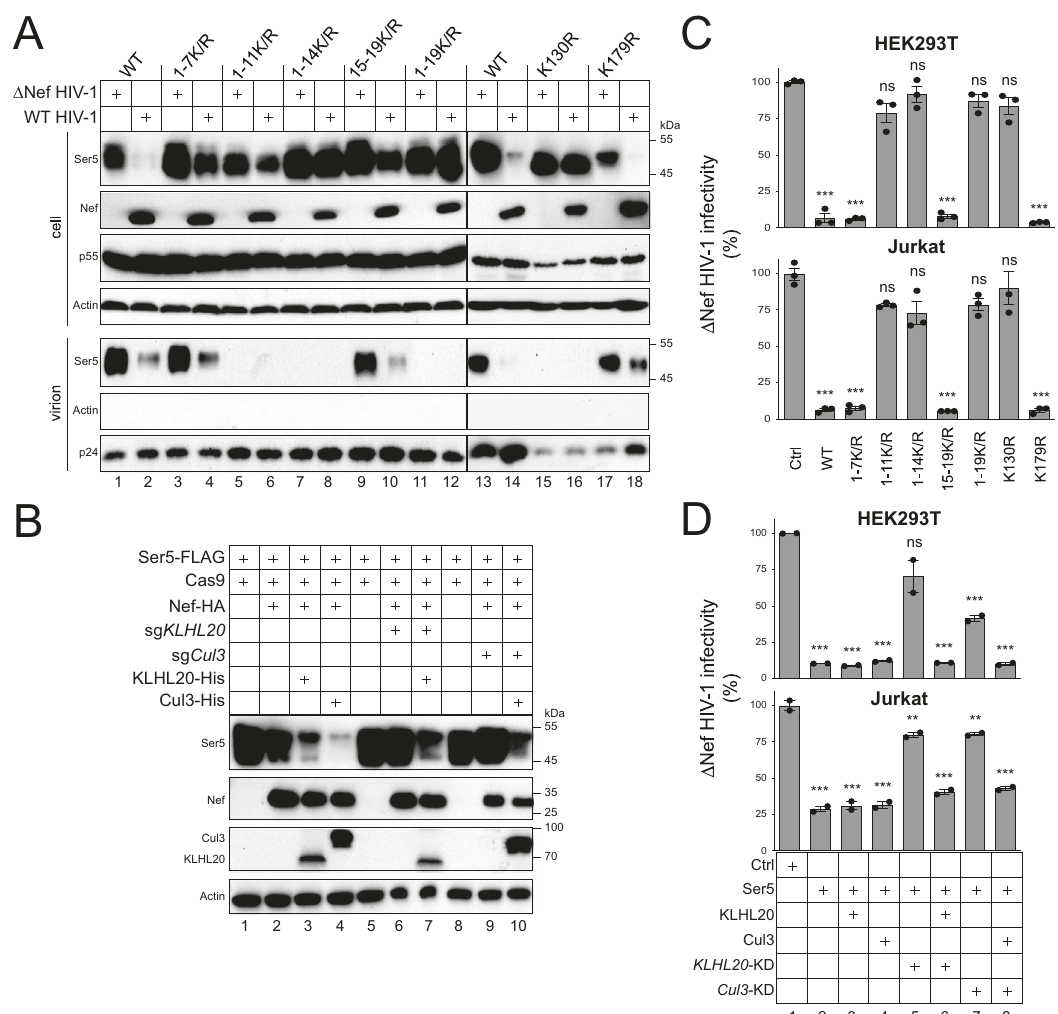
Fig. 6 Polyubiquitination is required for SERINC5 anti-HIV-1 activity. A WT and Δ Nef HIV-1 were produced from HEK293T cells in the presence of Ser5 and its lysine mutants. Virions were puri fi ed from culture supernatants via ultracentrifugation. Ser5 expression in cell lysate and virions were detected by WB. B Ser5 was expressed with Nef in HEK293T cells in the presence of ectopic KLHL20 and Cul3 expression and/or their KDs by CRISPR/Cas9. Ser5 expression was compared by WB. C Δ Nef HIV-1 was produced from HEK293T and Jurkat cells in the presence of Ser5 and its lysine mutants. After normalization by p24 Gag ELISA, viral infectivity was analyzed after infection of HIV-1 luciferase reporter cell line TZM-bI. D Δ Nef HIV-1 was produced from HEK293T and Jurkat cells in the presence of SERINC5, ectopic KLHL20 and Cul3 expression, and/or their KDs by CRISPR/Cas9. Viral infectivity was analyzed similarly as in C ). For C and D , results are presented as relative values, with the infectivity of viruses produced in the presence of a control vector (Ctrl) vector set as 100. Error bars indicate SEMs calculated from two or three experiments. n = 3 ( C ) or n = 2 ( D ); One-way ANOVA Tukey test; ns, not signi fi cant; * p < 0.05, ** p < 0.01, *** p < 0.001. All experiments were repeated twice, and representative experiments are shown. Source data are provided as a Source Data fi